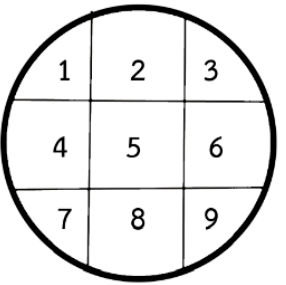
Figure 2. Fixed location of the nine illuminance measurements at the top and bottom end positions of light tube.